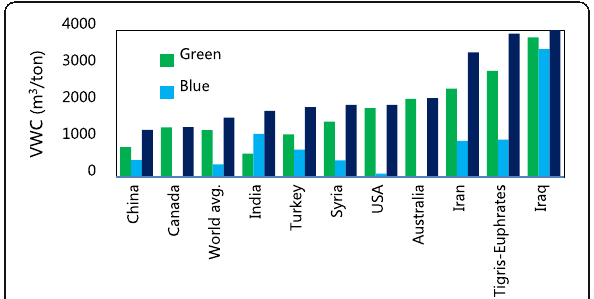
Fig. 3 Green, blue and total virtual water contents of wheat in Turkey (this study), neighboring regions and major wheat producing countries. (Other countries ’ data is based on Mekonnen and Hoekstra,